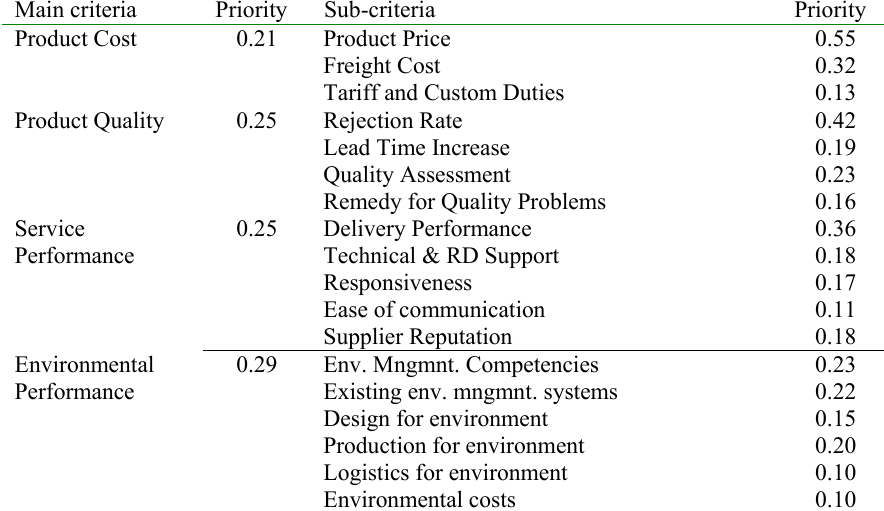
Table 22. Main and sub-criteria weights for green supplier selection